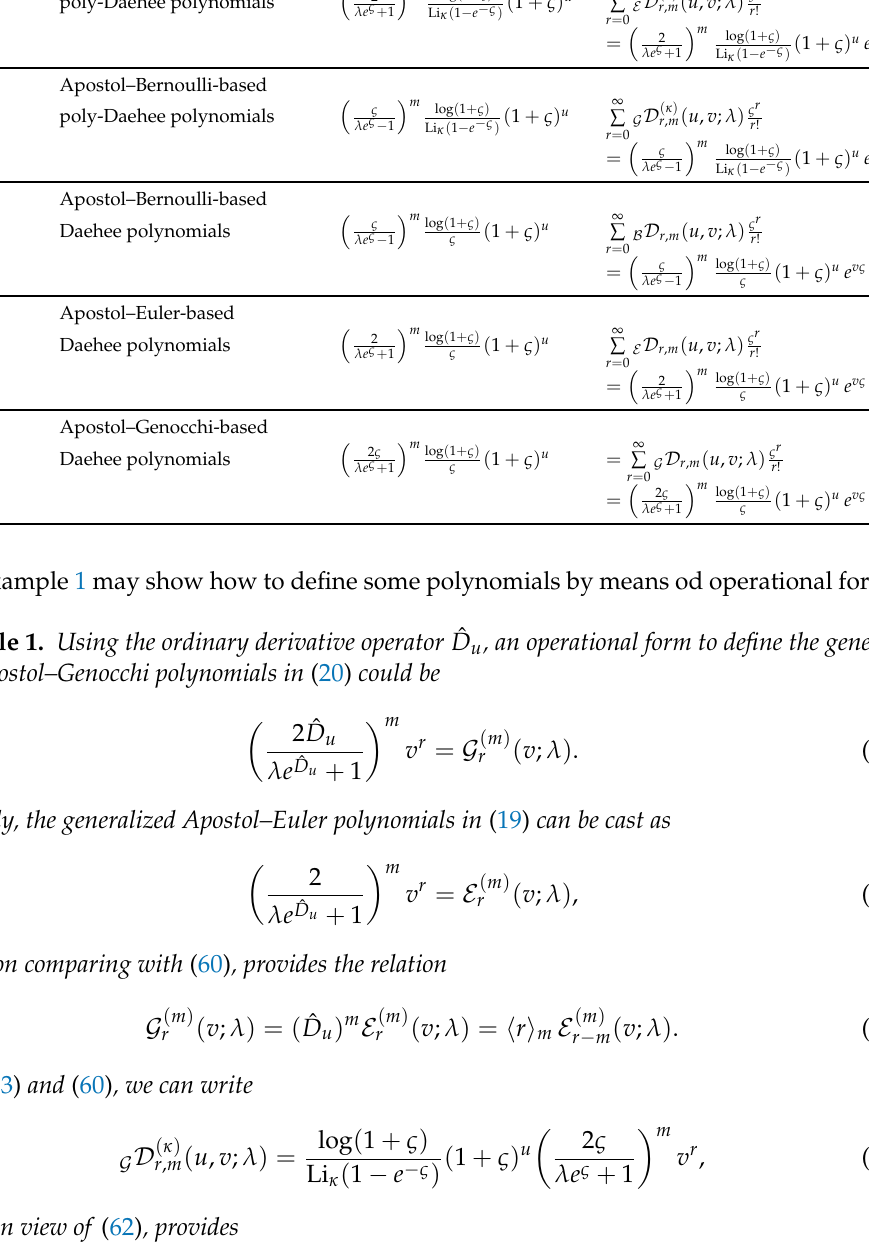
Table 2. Members similar to the polynomials G D